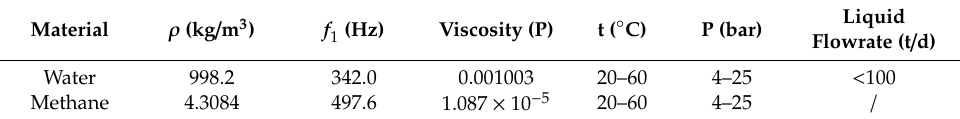
Table 2. Inlet setting ranges of gas-liquid two-phase flow